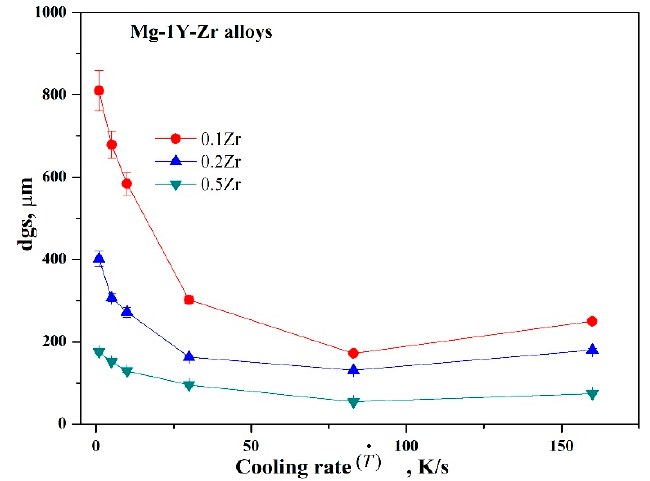
Figure 9. Effect of cooling rate ( ˙T ) on the grain size ( d gs ) of Mg-1Y-Zr alloy [63]. Reprinted with permission from ref. [63]. Copyright 2020 Springer.